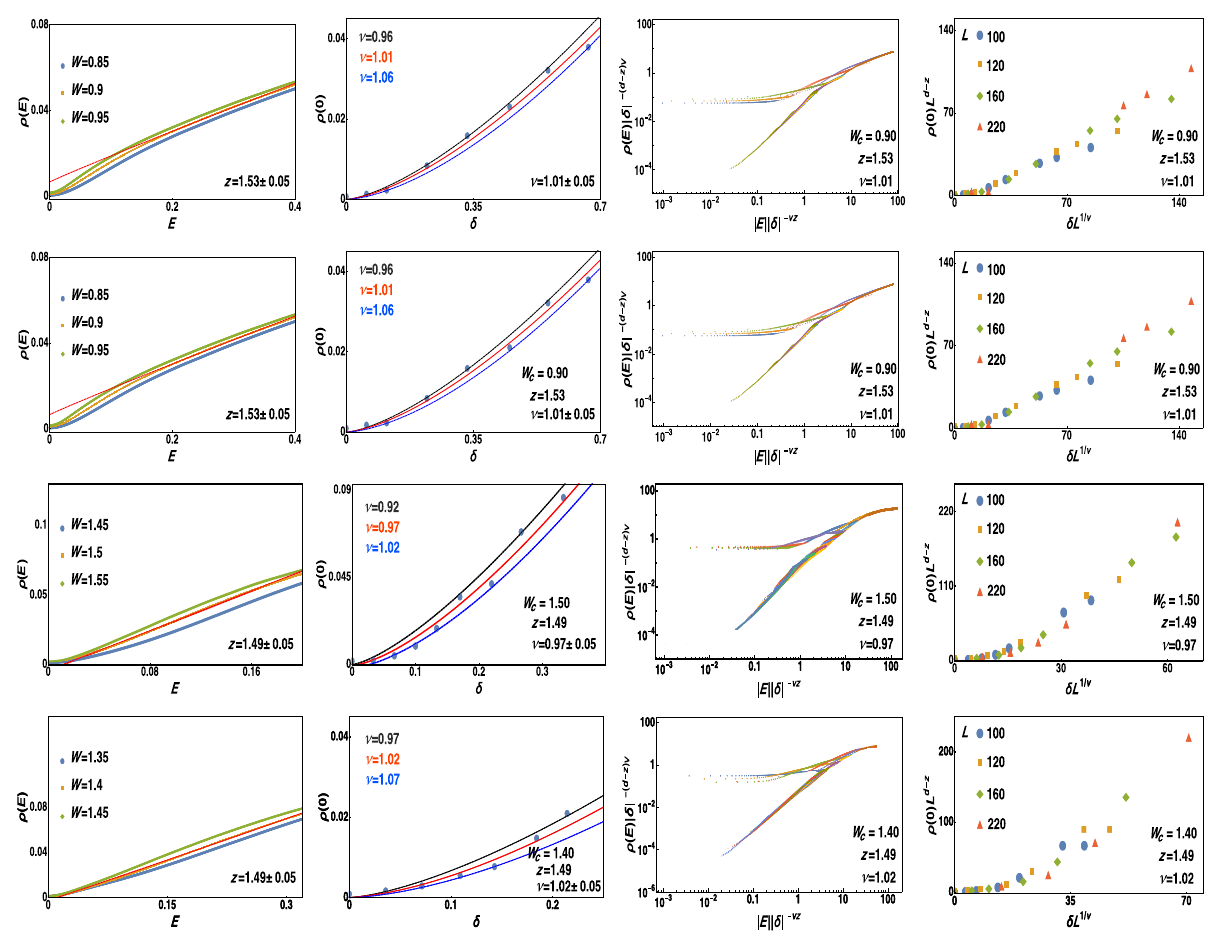
FIG. 14. Scaling analysis of numerically extracted ADOS in various regimes of the phase diagram of a dirty WSM in the presence of internode scattering. Each column is identical to the corresponding one in Fig. 13 (including methods of analysis and system size). The plots from top to bottom rows correspond to temporal ( Δ mass disorder (see Table III). Final results of our analysis are quoted in Table II. The quoted error bars in z and ν are fitting error bars. See also Appendix E and Table IV (from fourth to eighth row) for additional